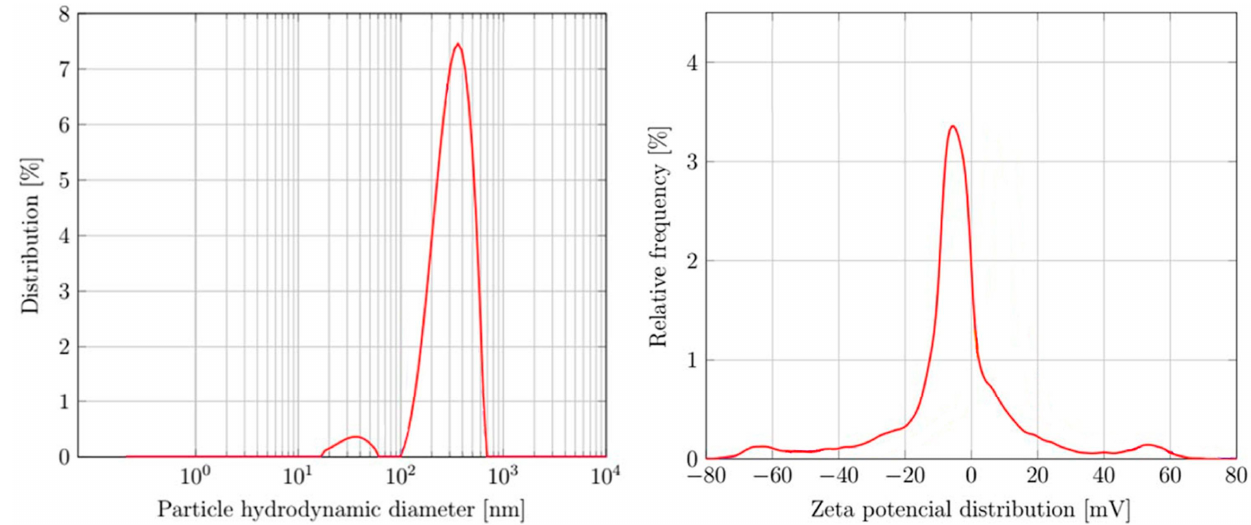
Figure 3. Particle size distribution from the DLS measurements and zeta potential distribution. Table 2. DLS measurements’ average particle size